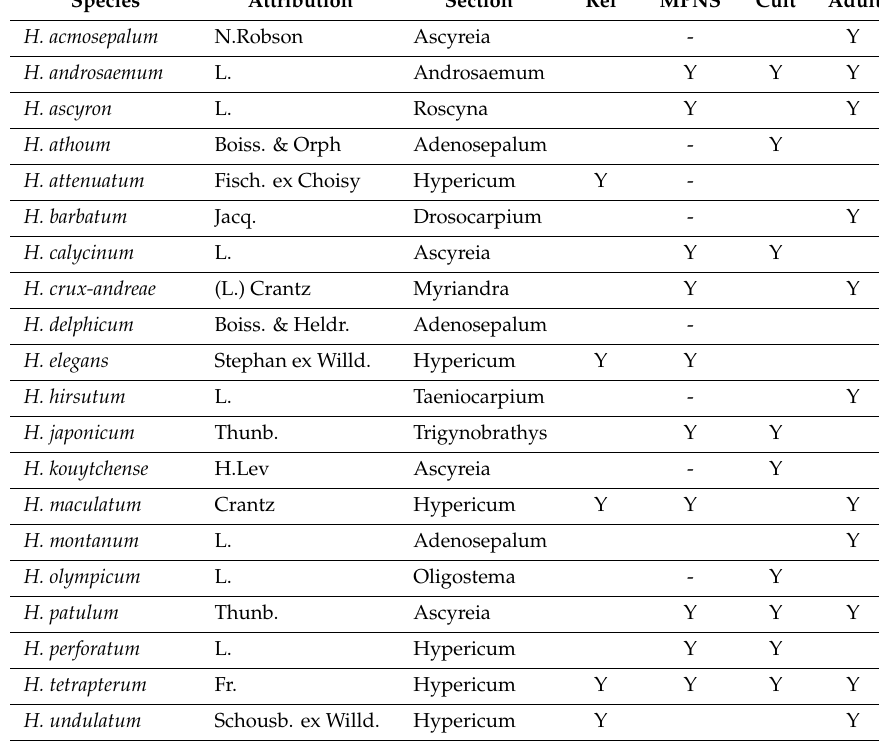
Table 6 indicates the criteria met for selection of each species as known or potential adulterants and / or close relatives. Table 6. Hypericum species included in the restricted panel. The criteria for choosing these species are indicated in the columns: Rel, close relatives of H. perforatum in the Section Hypericum; MPNS, medicinal plants listed in the Medicinal Plants Names Service with at least one medicinal plant reference [32]; Cult, ornamental plants listed in the RHS horticultural database http: // apps.rhs.org.uk / horticulturaldatabase / index.asp; Adult, plants identified as adulterants of commercial St John’s Wort herbal products